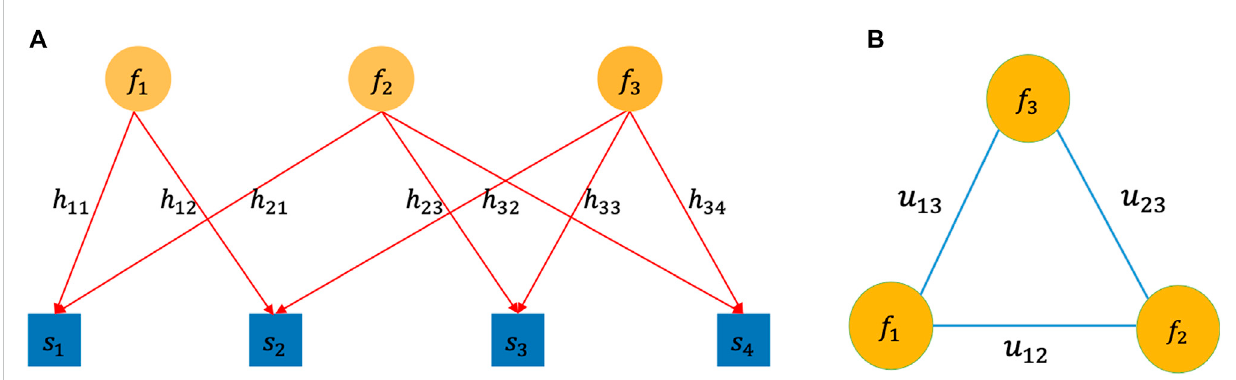
FIGURE 1 (A) Bipartitegraphbetweenfundsandstocks. (B) Projectedfundnetwork.InFigure1A, f i denotesfund i , i (cid:1) 1 , 2 , ... , N . s j denotesstock j,j (cid:1) 1 , 2 , ... , K . h